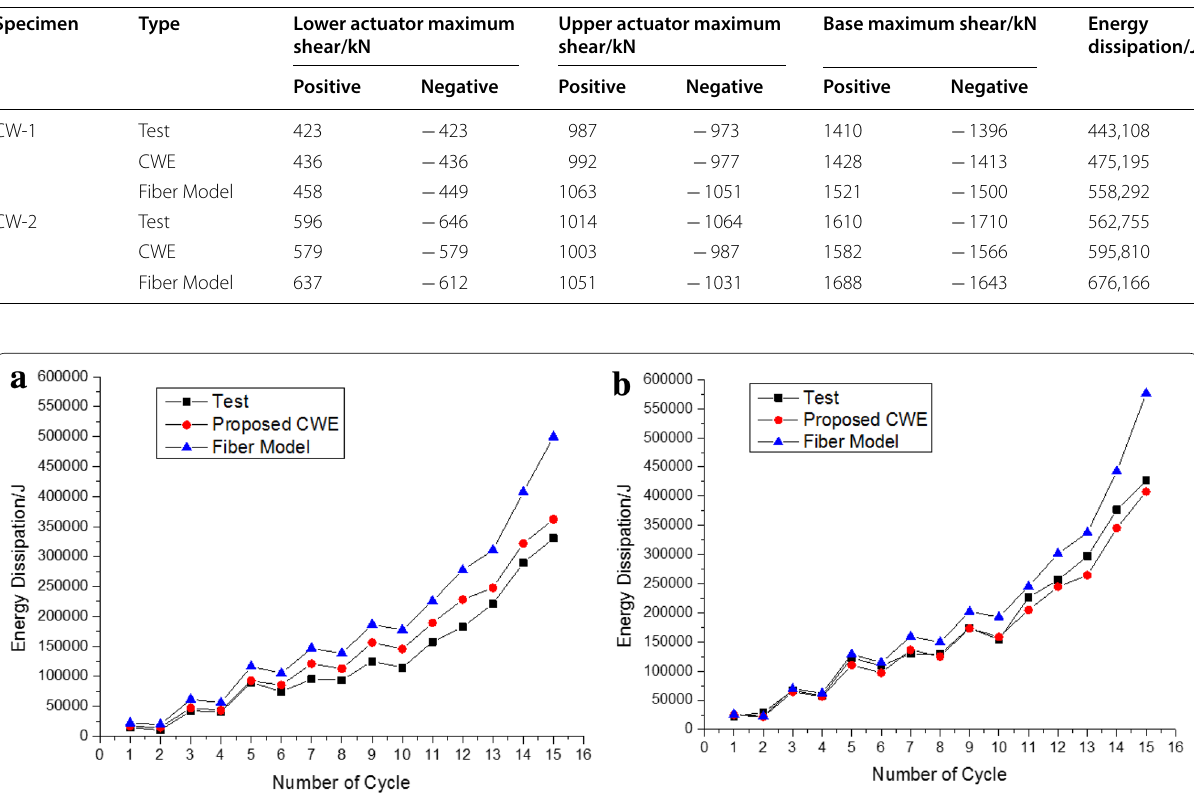
Fig. 18 Comparisons in energy dissipations obtained from experimental data, proposed CWE model, and fiber model in each number of cycle: a CW-1 and b